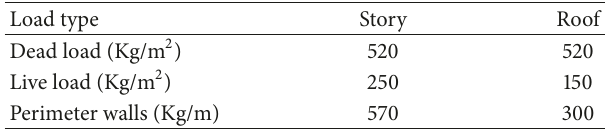
Table 2: Gravity